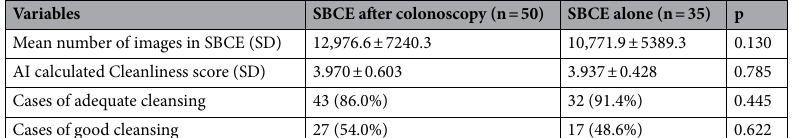
Variables Mean number of images in SBCE